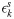
Test 2: Trend of the relative error over time.Relative error ϵks vs. t˜ with n = 5 for the testing-parameter instance μtest = 0.9625 cm (the red band indicates the IQR). The error distribution is almost uniform over time.